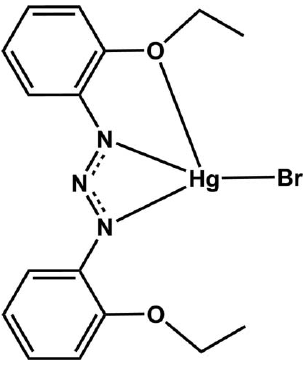
Experimental Crystal data